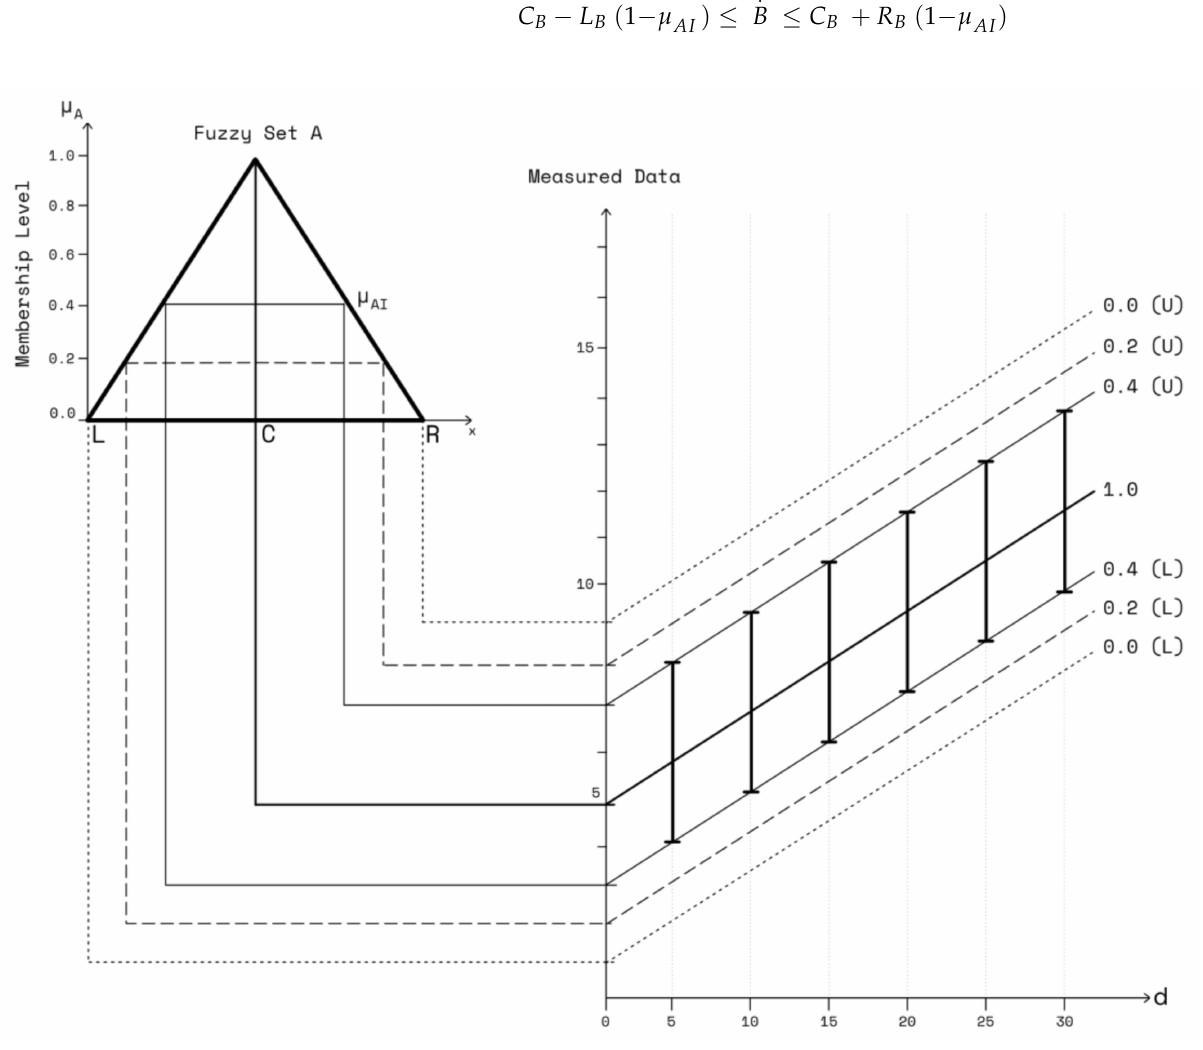
Figure 1. Concept of